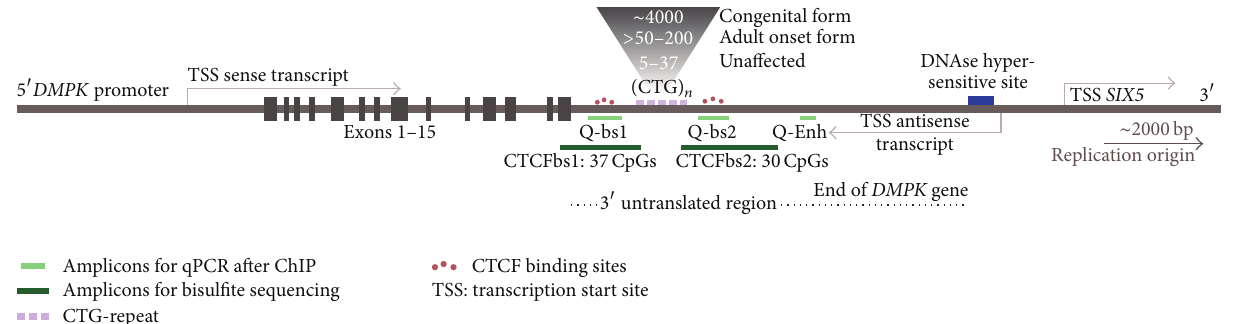
Figure 1: DM1 locus: schematic drawing of the DM1 locus, indicating relevant sites and regions, including the expanded CTG-repeat with flanking CTCF-binding sites (CTCFbs), the DNAse hypersensitive site enhancer of SIX5 , and transcription start sites (TSS) of the genes located at the DM1 locus. Approximate locations of amplicons used for bisulfite sequencing and qPCR after ChIP are indicated. The 45 kb fragment of genomic DNA that was used to generate the DM300 transgenic mouse line used in this study contains all of the features indicated in this